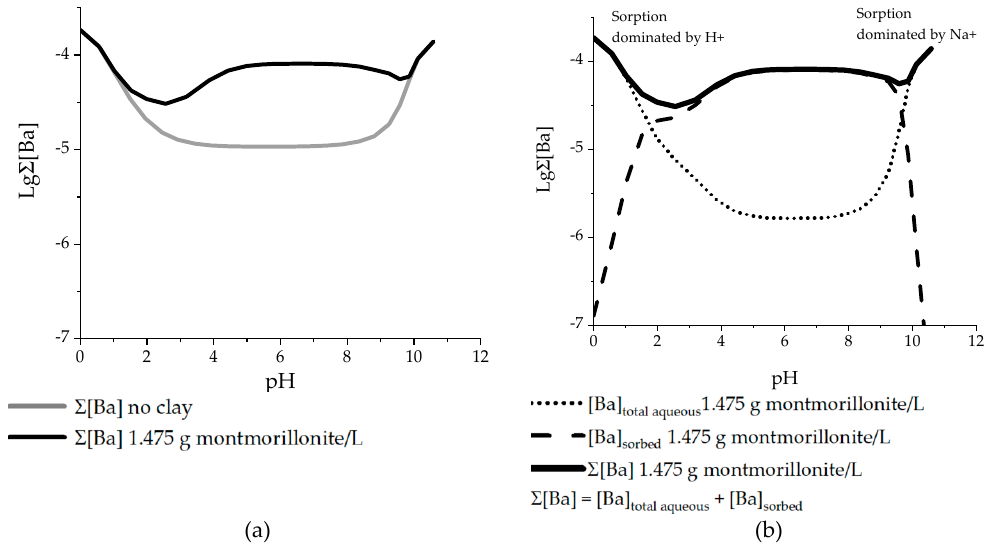
Figure 1. Solubility of barite in deionized (DI) water. ( a ) Concentration in mol/L of total Ba dissolved in a DI water solution in equilibrium with pure barite or with barite and 1.475 g montmorillonite per liter (i.e., 0.59 g per 40 mL). The solution pH is adjusted with HCl or NaOH. The clay minerals are initially put in equilibrium with a 1M CaCl 2 solution for the occupation of the clay minerals sorption sites to be close to the Ca-dominant case of this study. ( b ) Distribution of the total Ba dissolved between aqueous Ba in solution and sorbed Ba in mol/L in a DI water solution in equilibrium with barite and 1.475 g montmorillonite per liter. The solubility of the barite is determined by Σ [Ba] = [Ba] total aqueous + [Ba] sorbed .